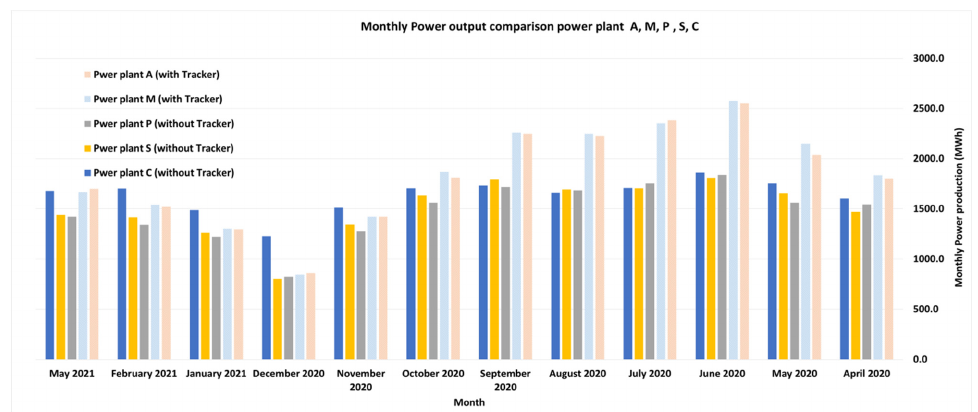
Figure 9. Monthly energy production of five 10 MW solar power plants in Yazd province. By excluding power plant C from the calculations and averaging the production of the two power plants with/without solar trackers, the average net production and annual equivalent production of the power plants with trackers were 23% higher (the average of the coefficients applied in 2020 was 0.9). Figure 10 shows the percentage of changes in the monthly production of the power plants due to the use of the tracker.